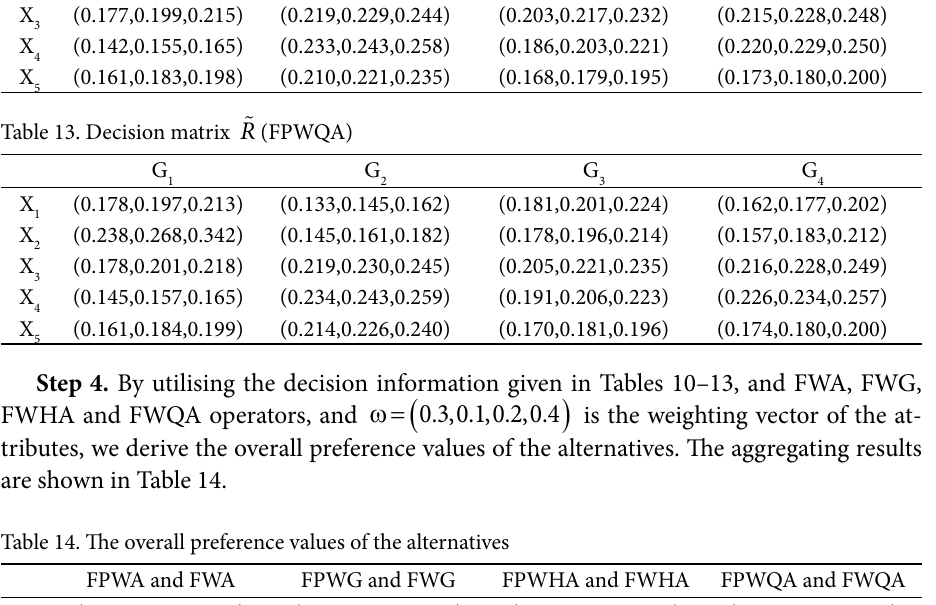
Table 13. Decision matrix R  (FPWQA)